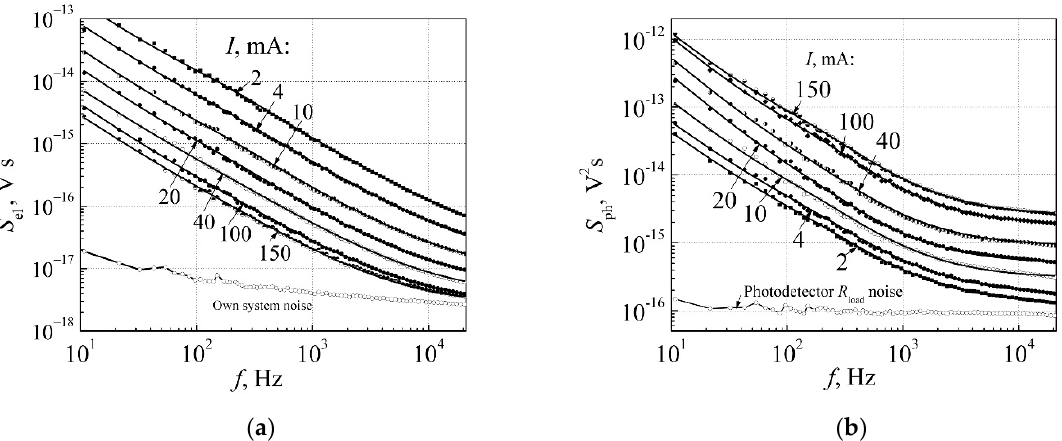
Figure 6. Electrical ( a ) (dots are experimental results, solid lines are calculated by Equation (2)) and optical ( b ) (dots are experimental results, solid lines are calculated by Equation (3)) noise spectra of white 3 W InGaN LED at different forward currents before aging (optical noise has been measured by the broadband silicon photodetector). Reprinted with permission from [21].